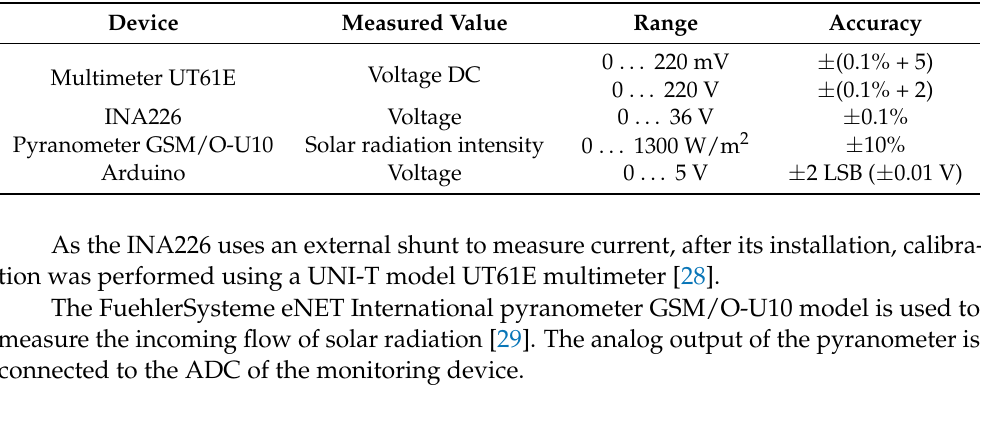
Table 2. Main metrological characteristics of the devices